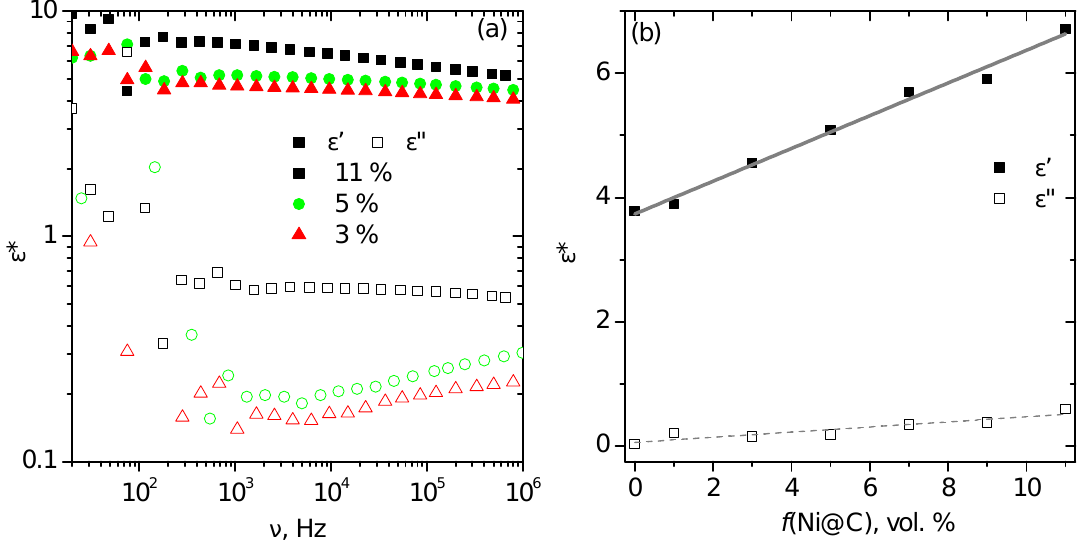
Figure 2. ( a ) Frequency dependence of the permittivity of Ni@C/PDMS composite with different amounts of embedded Ni@C particles, ( b ) dependence of the permittivity on Ni@C fraction at 4 kHz frequency(symbols), fit with Maxwell Garnett equation